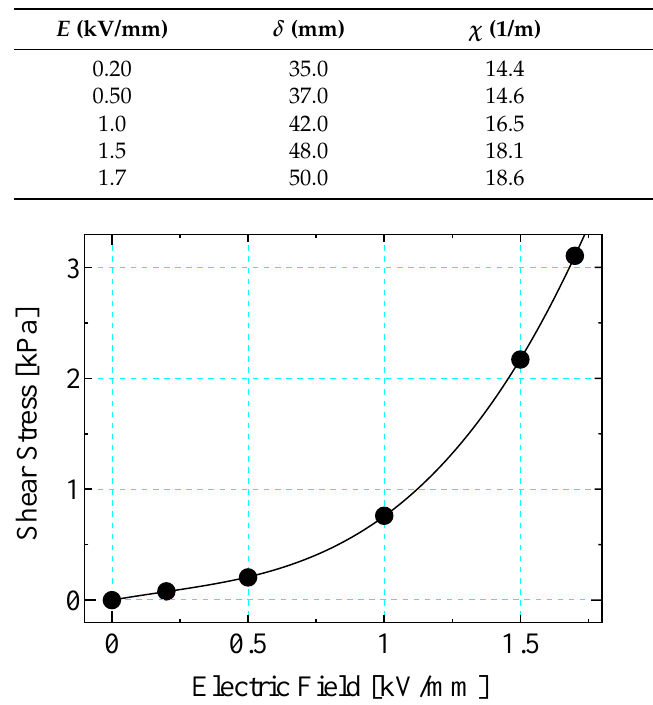
Figure 21. Shear stress on